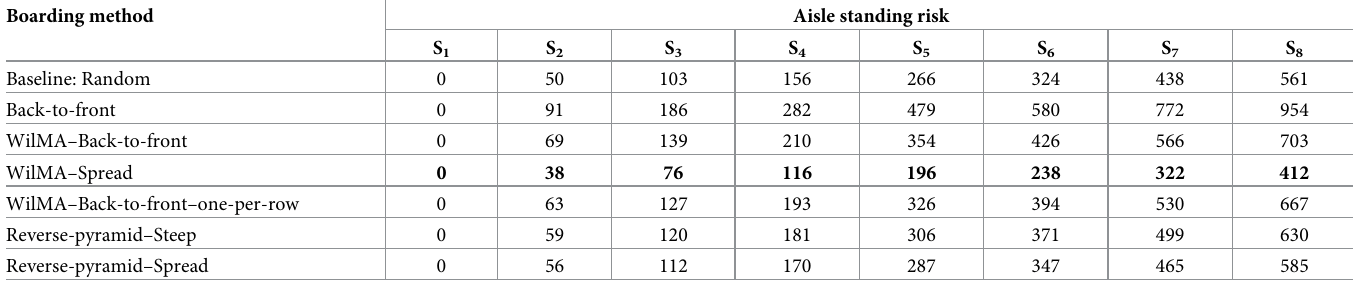
Table 6. Aisle standing